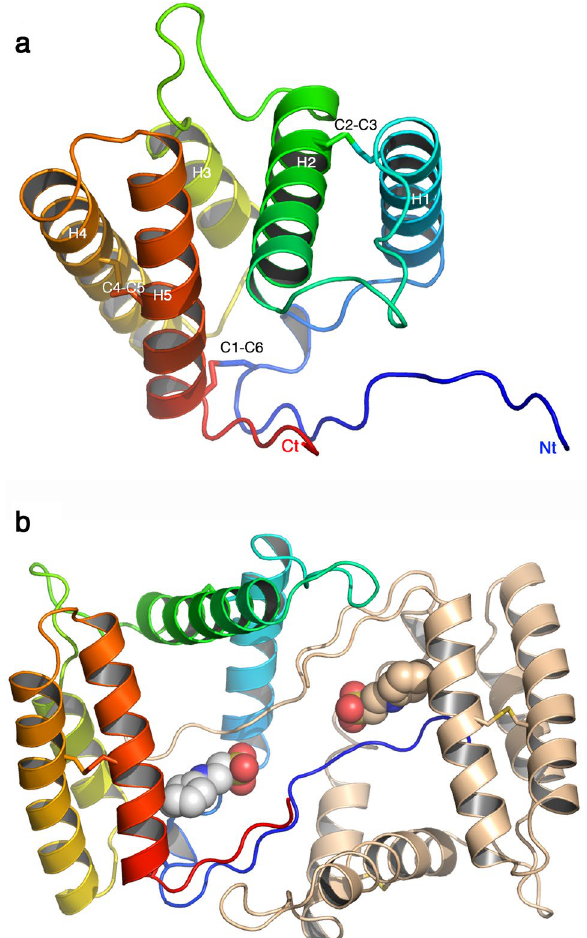
Figure 4. Crystal structure of VdesOBP1 form P2 1 . ( a ) Ribbon view of a monomer displaying helices 1–5 and disulphide bridges. The polypeptide chain is rainbow coloured, from blue (N-terminus) to red (C-terminus). The disulphide bonds are identified by the secondary structures they belong to. ( b ) Ribbon view of the crystallographic dimer. One monomer is rainbow coloured, the other one is coloured brown. The serendipitously bound buffer molecule 2-(N-cyclohexylamino)-ethane sulfonic acid (NCES) is displayed as atomic spheres (C: white, N: blue and O: red). Figure made with PyMOL (version 1.5.0.2. http:// www. pymol.